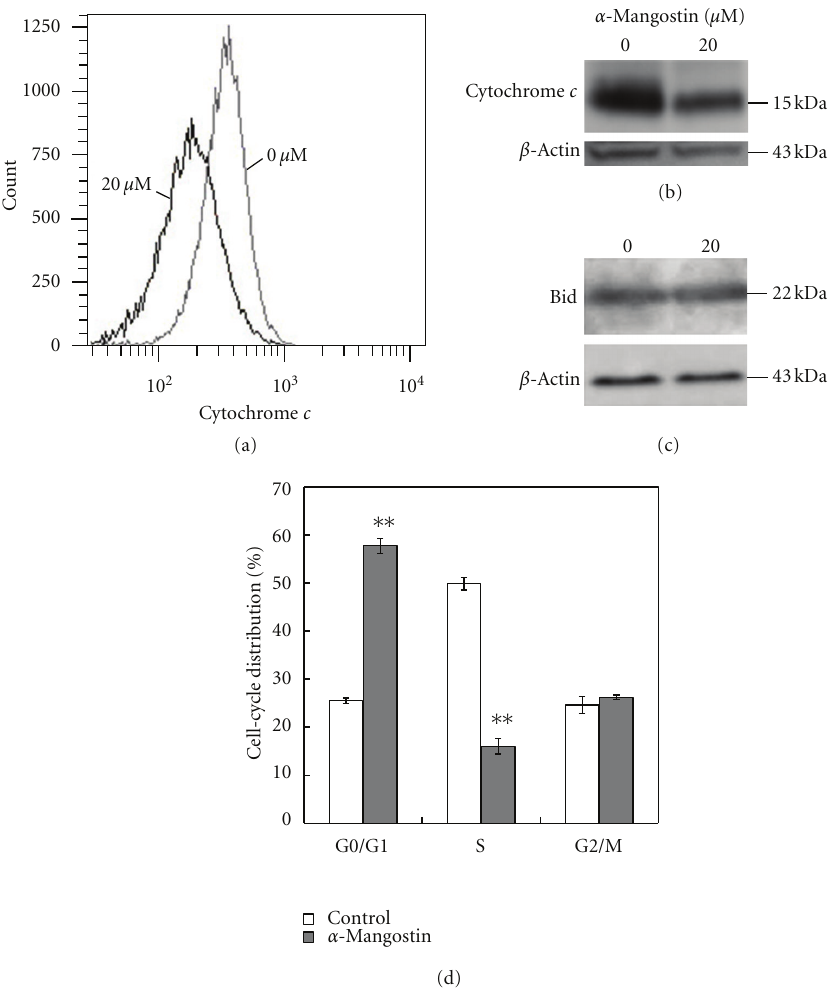
Figure 3: Cytochrome c expression, Bid cleavage, and cell-cycle distribution of MDA-MB231 cells after α -mangostin treatment. (a) Cytochrome c in mitochondria, as determined by flow cytometry (black line indicates α -mangostin-treated cells and gray line indicates controls). The levels of cytochrome c protein in mitochondrial fractions were significantly lower in cells treated with α -mangostin for 24 h (b). Western blots of cytochrome c (15kDa) showed significant decreases in cells treated with α -mangostin for 24 h, as compared to controls (upper panel). In α -mangostin-treated cells, cytochrome c was released from mitochondria, leading to decreases in concentration. β -Actin served as an internal control (lower panel, same in (c)). (c) Western blots of Bid (22kDa) in control cells and cells treated with α -mangostin for 24 h were similar (upper panel). Cleaved Bid was not observed after α -mangostin treatment. Three samples were used for all analyses in (a)–(c). (d) Cell-cycle analysis confirmed that α -mangostin induced arrest in the G1-phase and inhibition of cells entering the S-phase in MDA-MB231 cells ( ∗∗ P < 0 . 01). Data are presented as mean ± SD of triplicate, independent